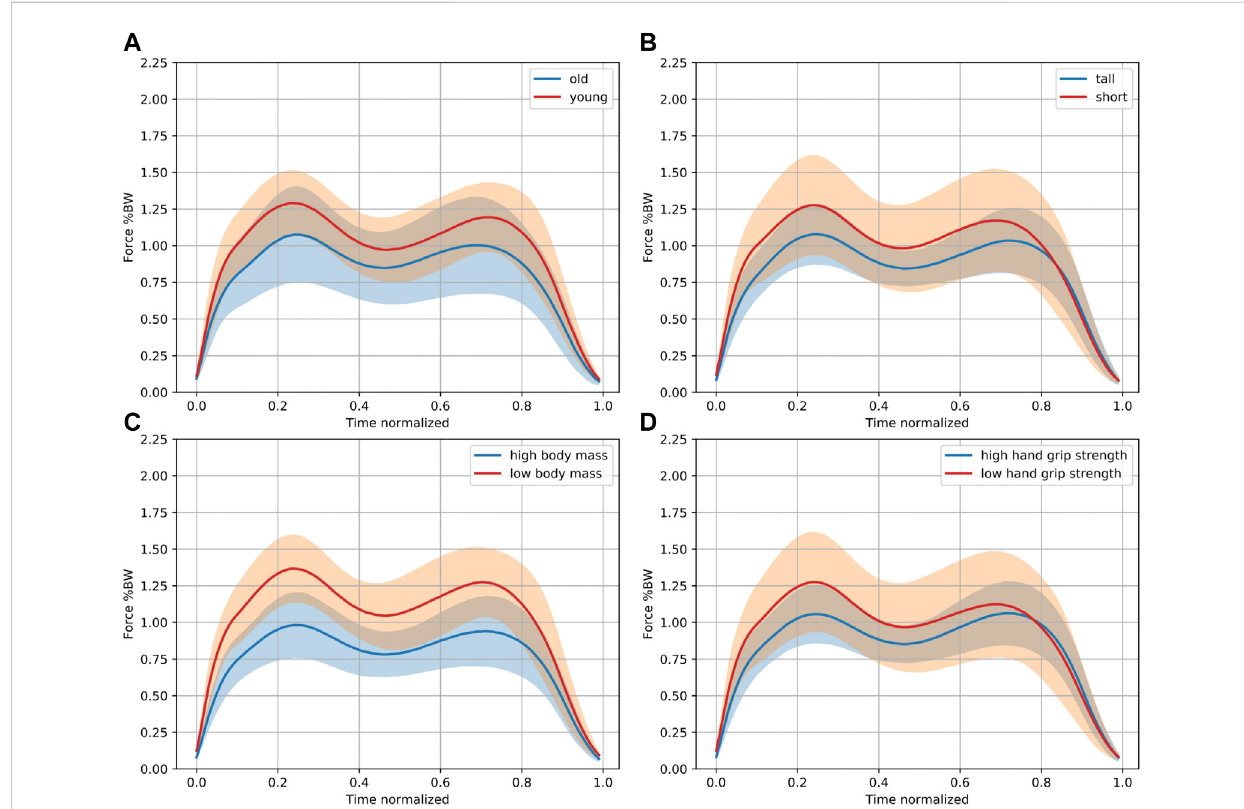
FIGURE 2 Characteristic differences in the stance phase curve. This fi gure is independent of the multiple regression analysis purely for illustration purposes. Pooled data of 18 out of 37 participants in each group are shown comparing the 18 (A) oldest and youngest participants, (B) tallest and smallest participants, (C) with the highest and lowest body mass, and (D) those with the highest and lowest handgrip strength. The solid lines indicate the mean. The95%con fi denceintervalsareshowninorangeandblue,whiletheoverlapshowsupinbrown.Highernormalizedforcevalues(in%bodyweight) can be observed in the younger and shorter participants with a lower body mass and handgrip